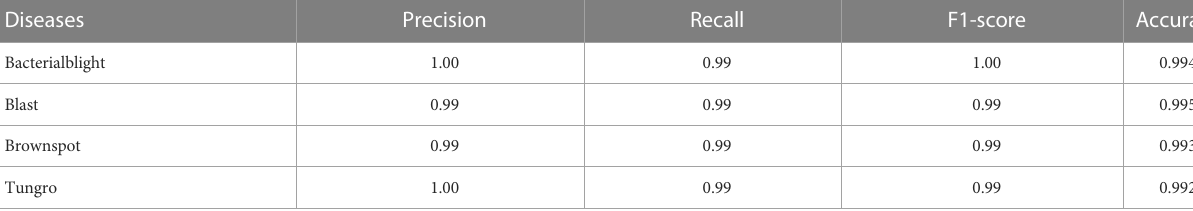
TABLE 4 GAN-MSDB-ResNet confusion